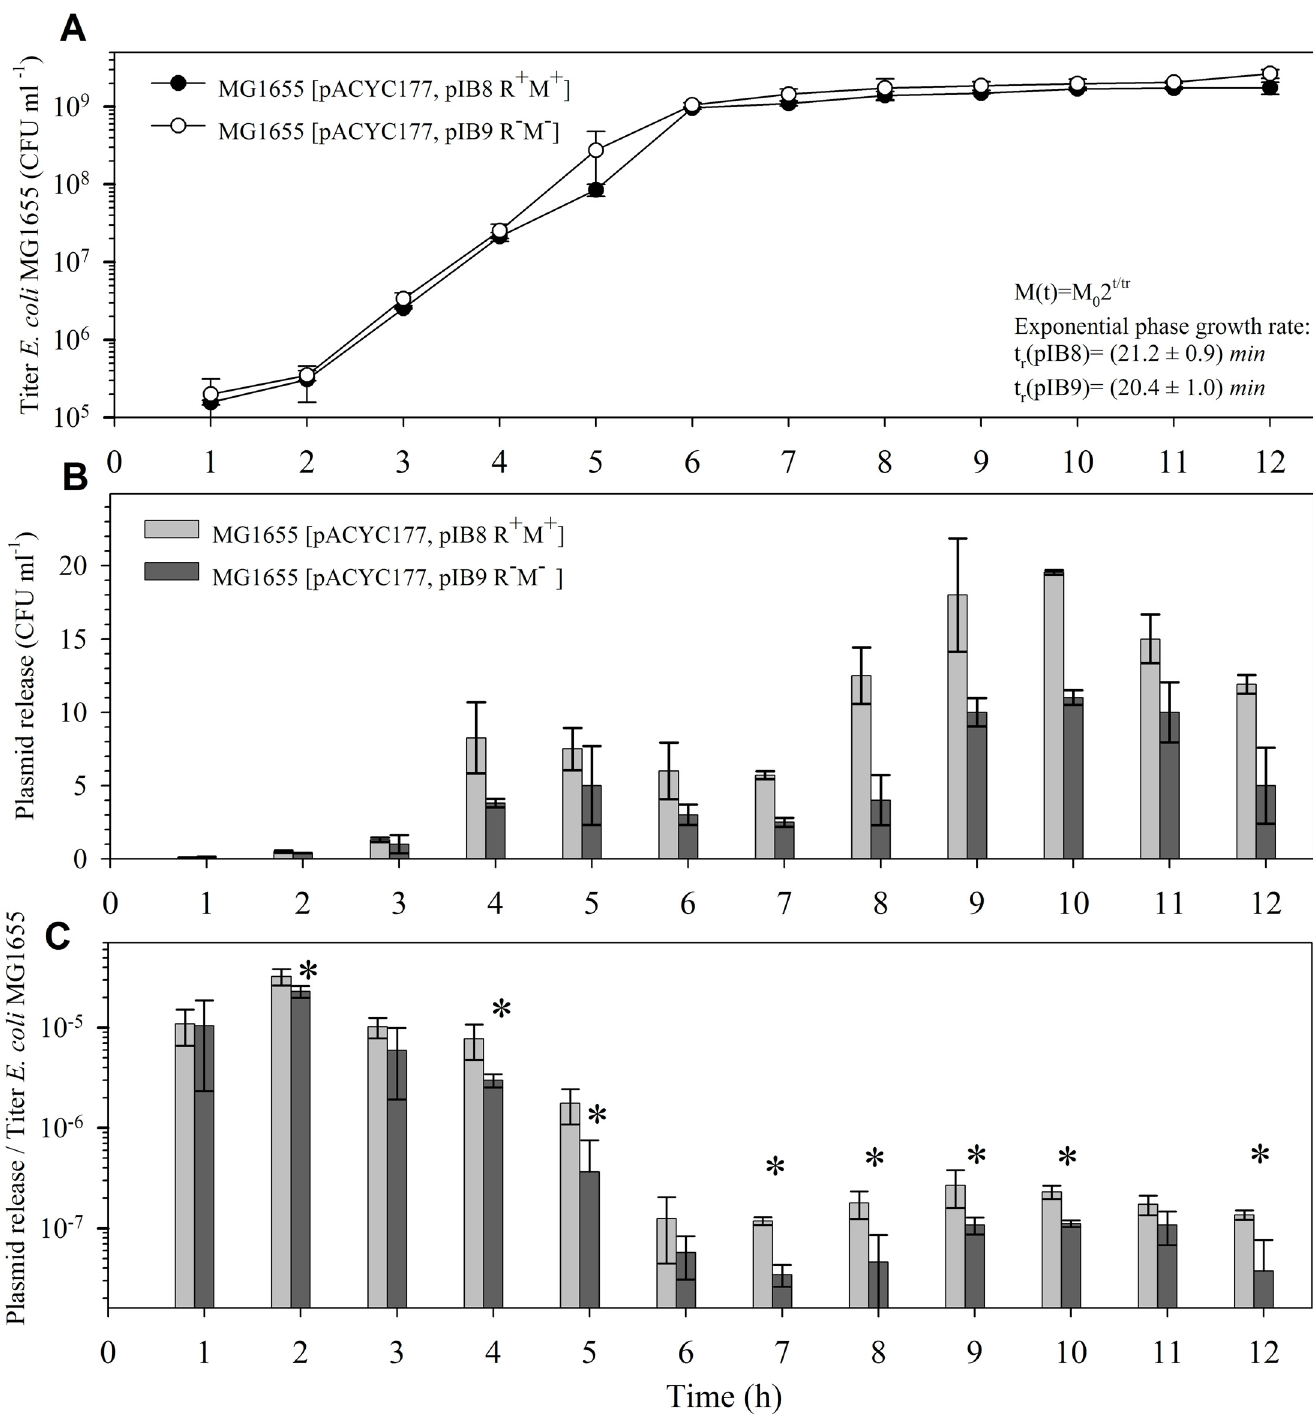
Fig 3. Effect of the EcoVIII RM system on plasmid release. Growth curves of E . coli MG1655 [pIB8, pACYC177] and MG1655 [pIB9, pACYC177] ( A ). Plasmid release indicated as number of pACYC177-positive transformants ( B ). The efficiency of plasmid release was determined as a ratio of transformants against the titer of the host ( C ). Each column represents the mean value ( ± standard deviation) from three repeats. Statistically significant differences in plasmid release as analyzed by Student ’ s t test, indicated by asterisk, were observed between bacteria carrying pIB8 (EcoVIII R + M + ) and those that carried pIB9 (EcoVIII R − M − ) ( P < 0.05; Student t test).